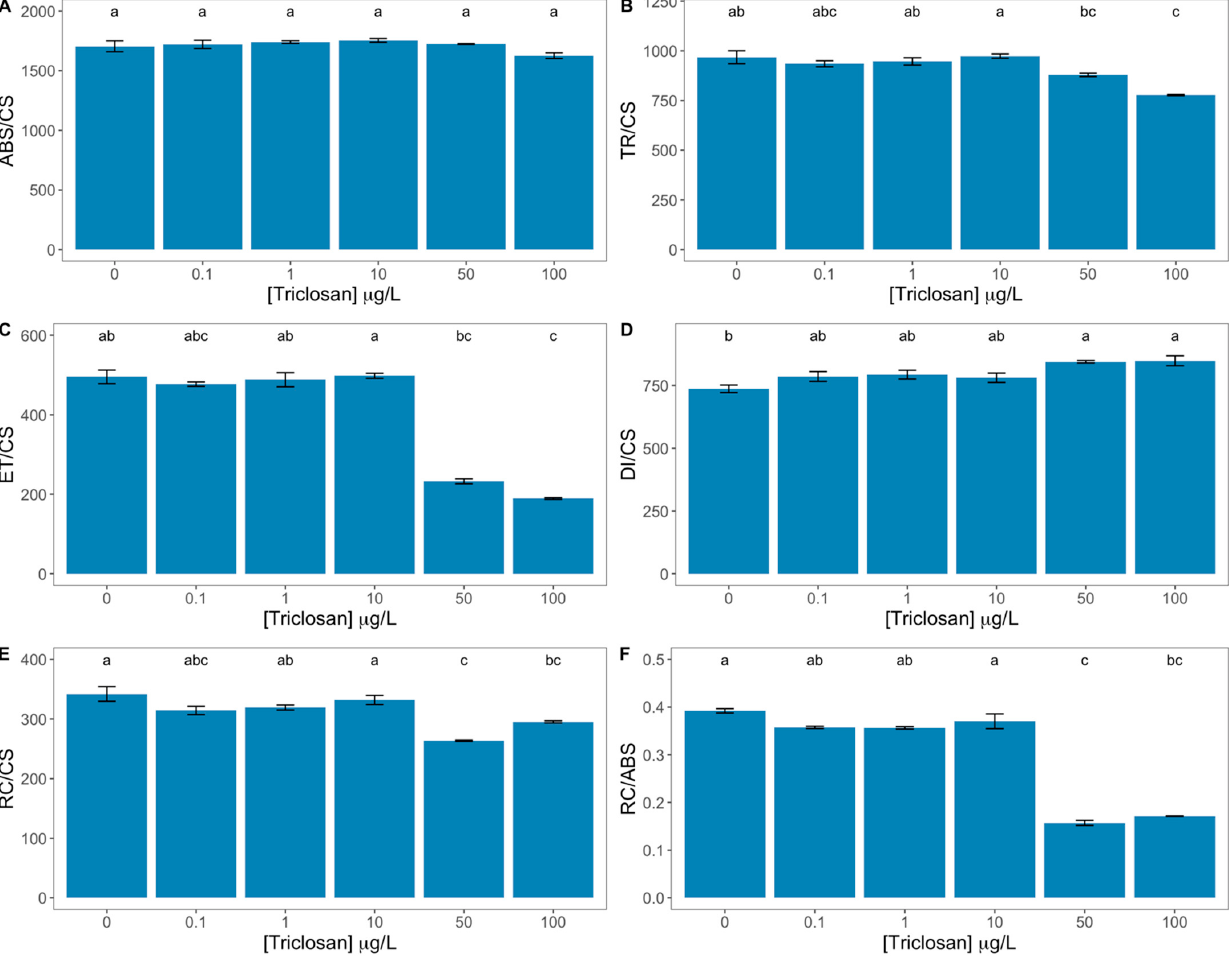
Figure 4. Triclosan-exposed Phaeodactylum tricornutum cultures phenomological energy fluxes [absorbed (ABS/CS, A ), trapped (TR/CS, B ), transported (ET/CS, C ) and dissipated (DI/CS, D ) energy fluxes], number of available reaction centres per cross-section (RC/CS, E ) and reaction centre II density within the antenna chlorophyll bed of PS II (RC/ABS, F ) (average ± standard error, n = 3; different letters denote significant differences between triclosan treatments at p < 0.05).